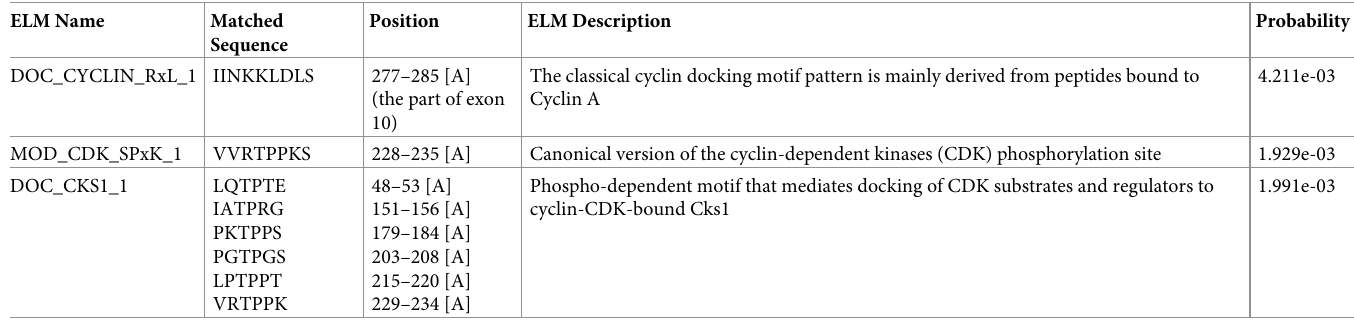
Table 1. ELM protein analysis. ELM predicted analysis [30] of Tau4R identified cyclin A docking motif, CDK-binding and phosphorylation site at threonine 231 and ser- ine 235, and multiple phosphorylation sites of